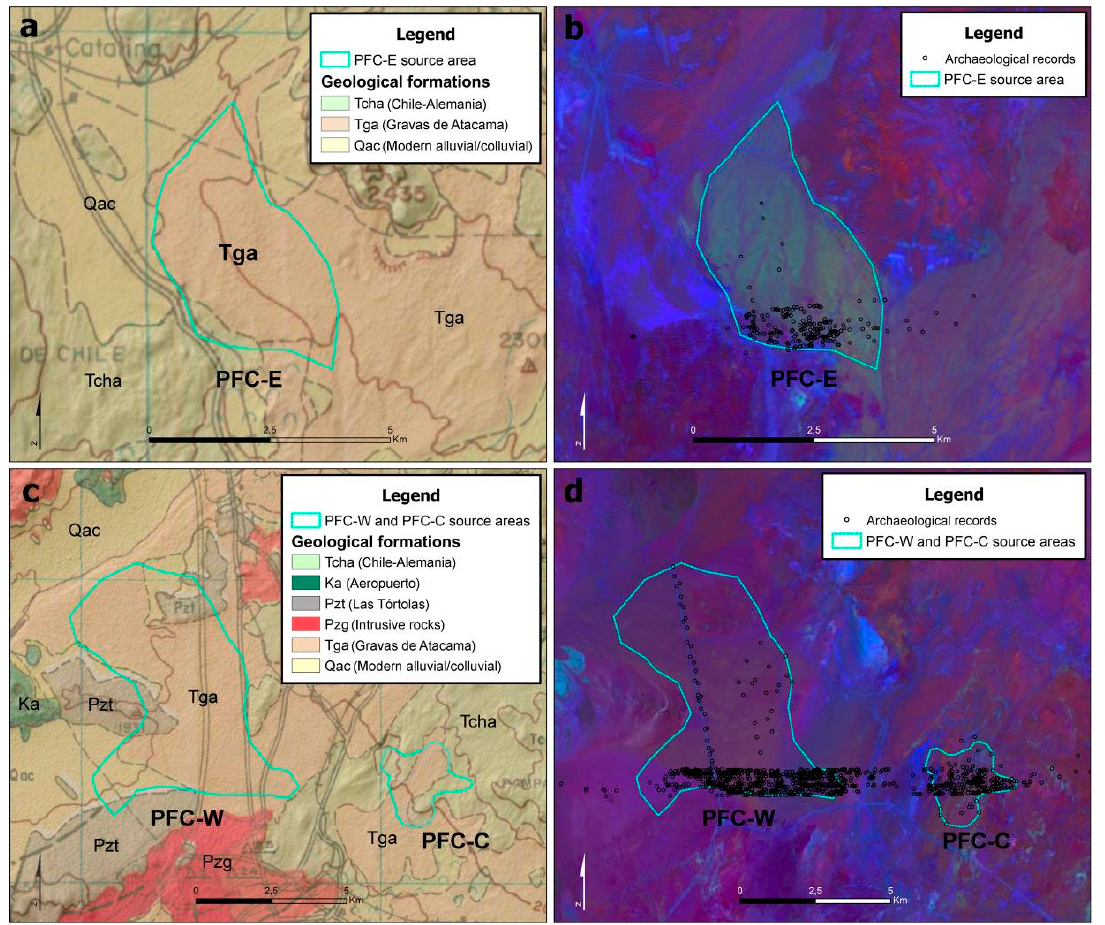
Figure 9. Comparison of 1:250,000 geologic map ( a , c ) [80] and band ratio 4/2-6/7-5 (RGB) false-color composite ( c , d ), showing the geographical setting of chert source areas: ( a , b ) Pampa Flor de Chile East; ( c , d ) Pampa Flor de Chile West and Pampa Flor de Chile Center.